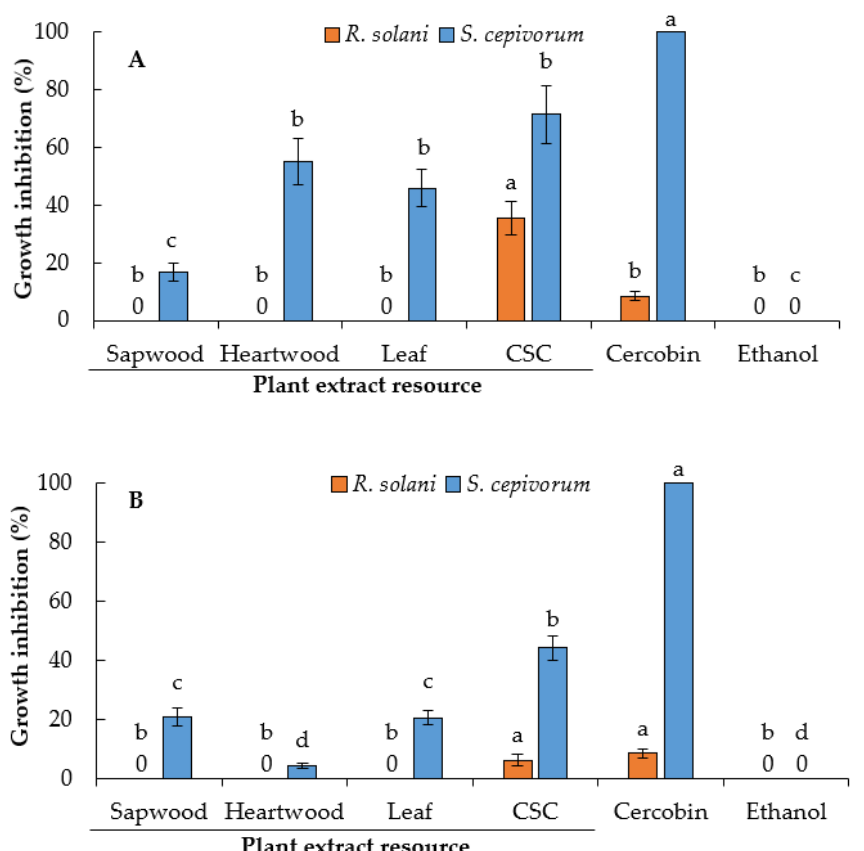
Figure 7. Effect of different source extracts of Eysenhardtia platycarpa on the inhibition of mycelial growth of Rhizoctonia solani and Sclerotium cepivorum at 72 h of culture: ( A ) Dichloromethane extract; ( B ) methanolic extract. CSC: Cell suspension culture. Values represent mean ± standard deviation of three replicates. Bars followed by the same letter between the same fungus are not significantly different ( p = 0.05) using Tukey’s multiple range test.